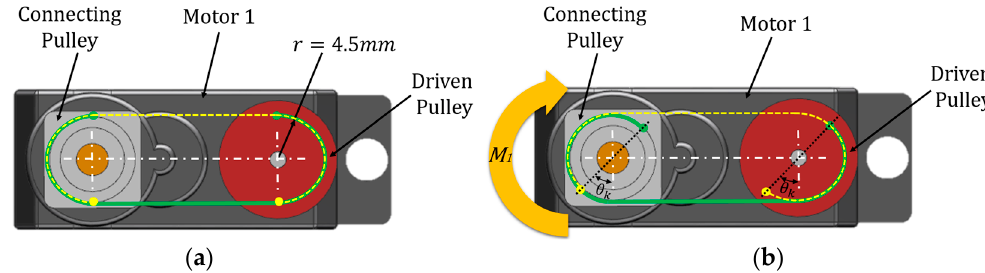
Figure 6. Synchronous winding structure: ( a ) initial state; ( b ) synchronous rotation state.